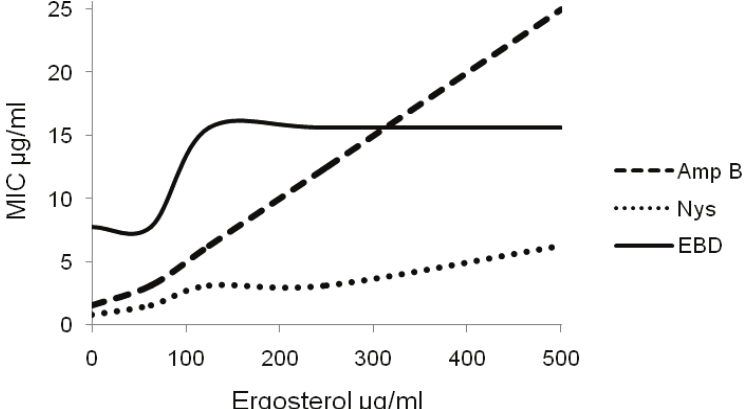
Figure 2. Ergosterol effect assay in T. rubrum – Exogen ergoterol (62.5 – 500 µg/mL) was added on the MIC of the dichlomethane extract (EBD), amphotericin B (Amp B) and nystatin (Nys).